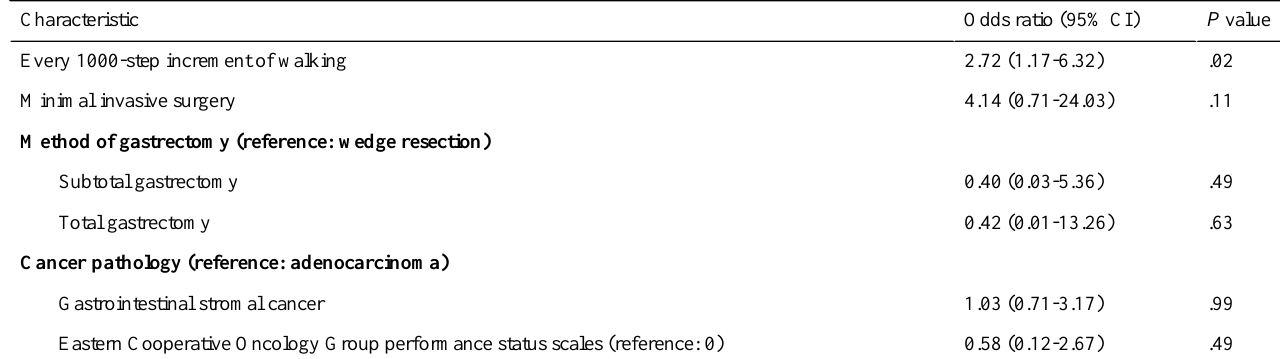
Table 3. Adjusted multivariate analysis to predict early